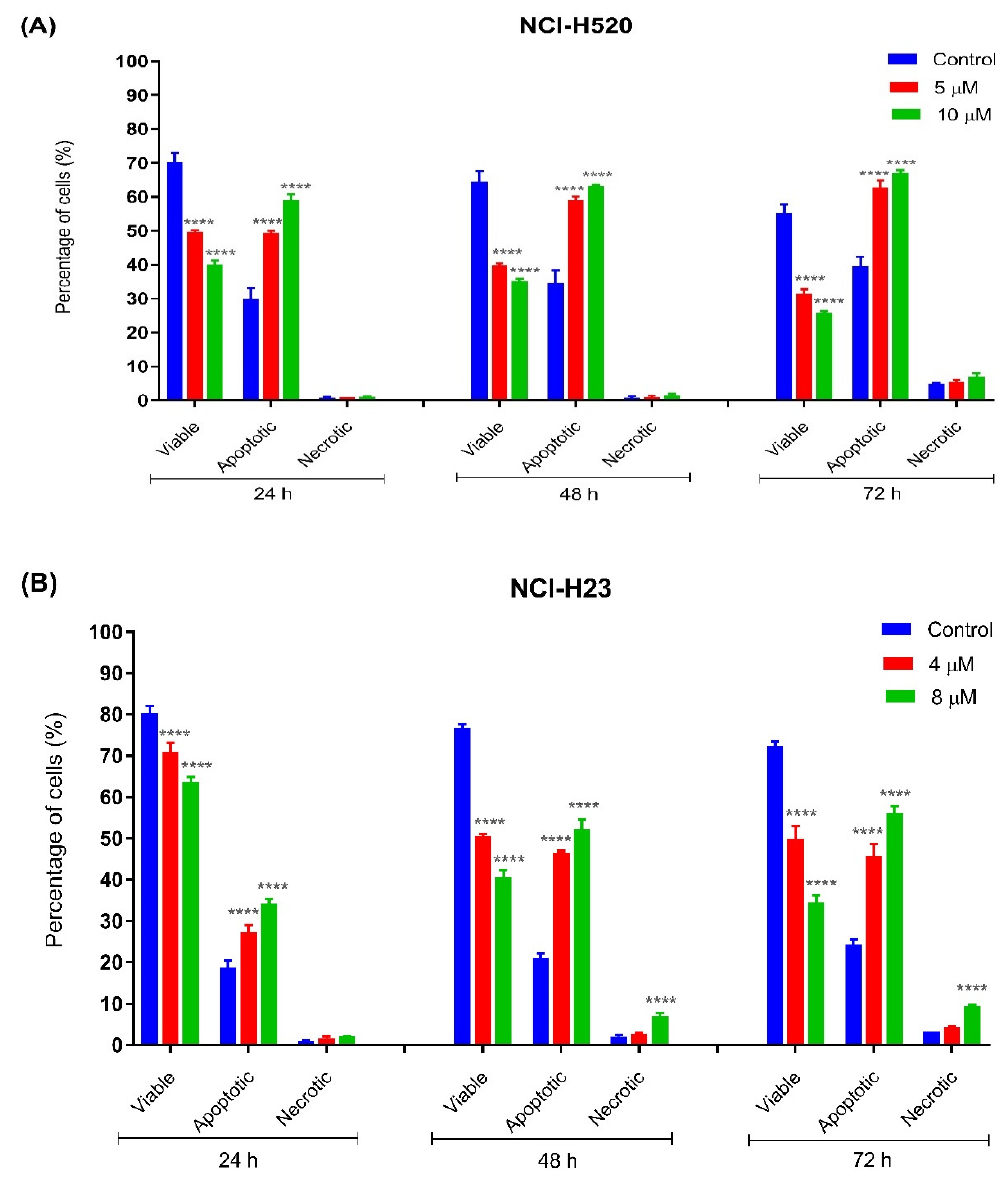
Figure 5. Percentage of cell population in ( A ) NCI-H520 and ( B ) NCI-H23 cells treated with MS13 for 24, 48, and 72 h. Treated and non-treated cells were double stained with AO/PI and a minimum of 200 cells were counted per sample and the percentage of cells from each population (viable, apoptotic, and necrotic) was calculated. Samples were run in triplicates and comparable results were obtained from three independent experiments. Comparison between data sets was performed using ANOVA. **** p < 0.0001 indicates statistically significant differences between the means of values obtained with treated vs.